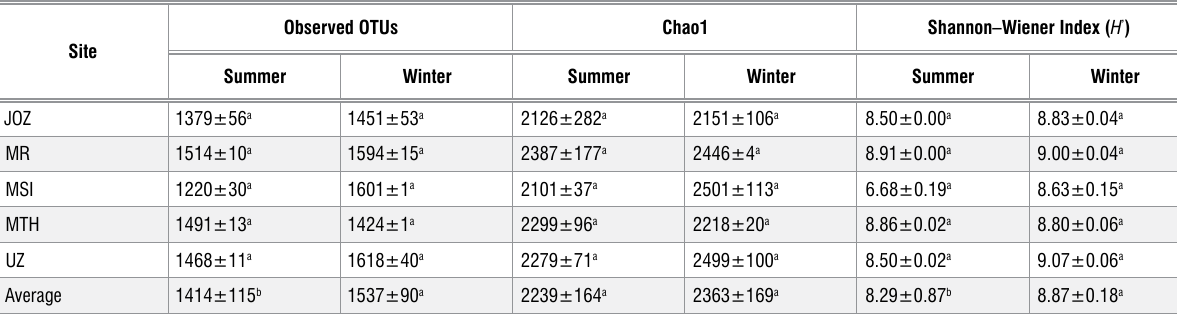
Alpha diversity indices of faecal bacteria of Zulu sheep